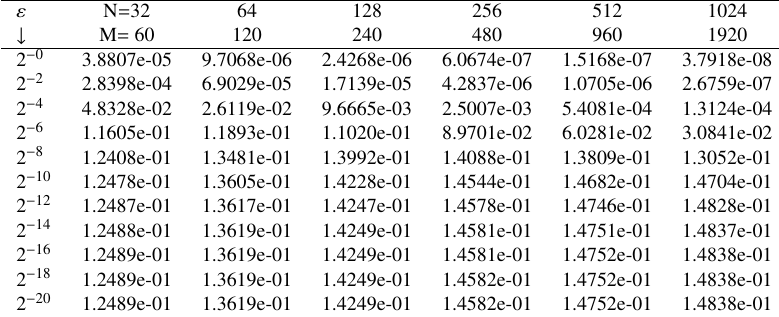
Table 6. Example 4.2, maximum absolute errors of the proposed scheme for δ = 0 . 6 ε and η = 0 . 5 ε . ε N = 32 2 − 0